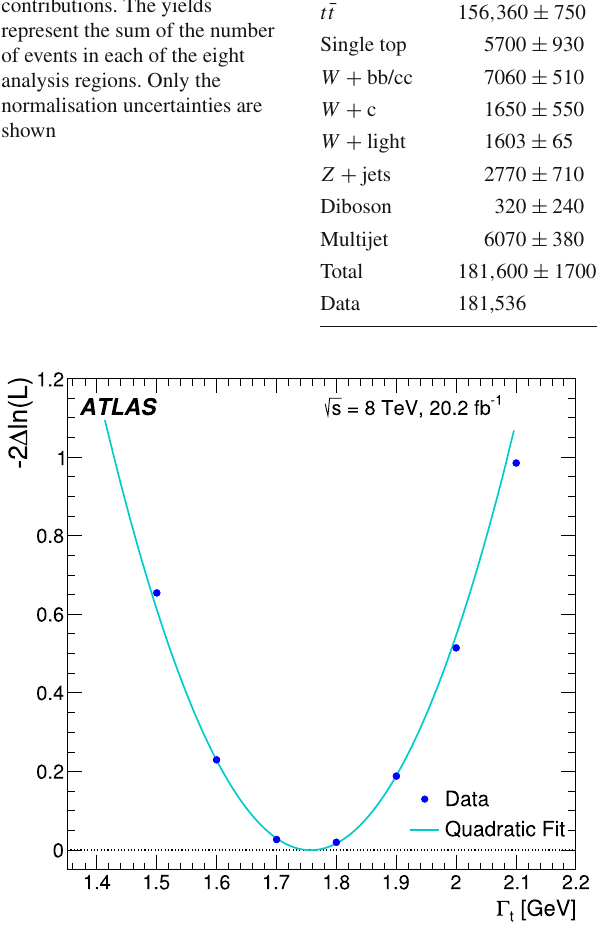
Fig. 6 Twice the negative logarithm of the likelihood obtained from the binned likelihood template fit to data. A quadratic fit is performed around the minimum